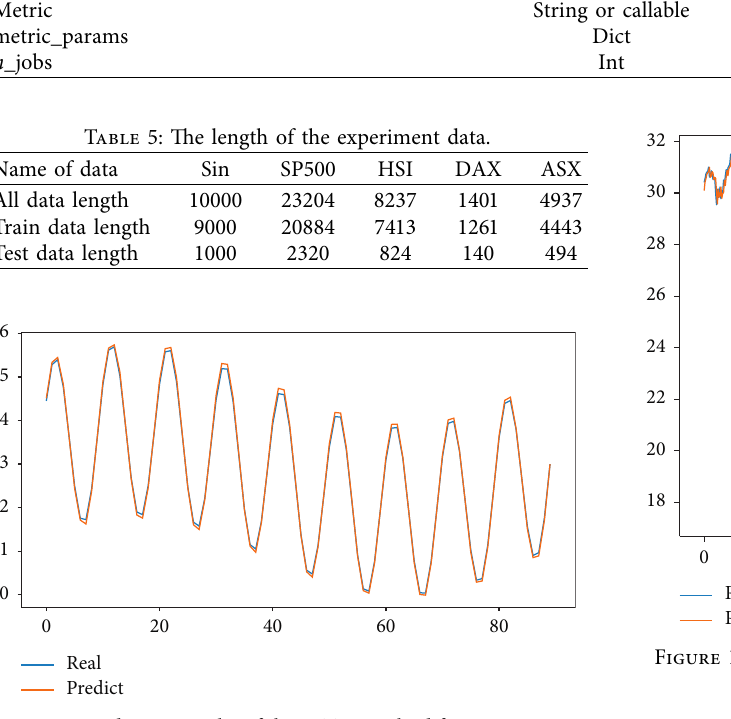
Figure 9: Prediction results of the LSTM method for sin sequence.